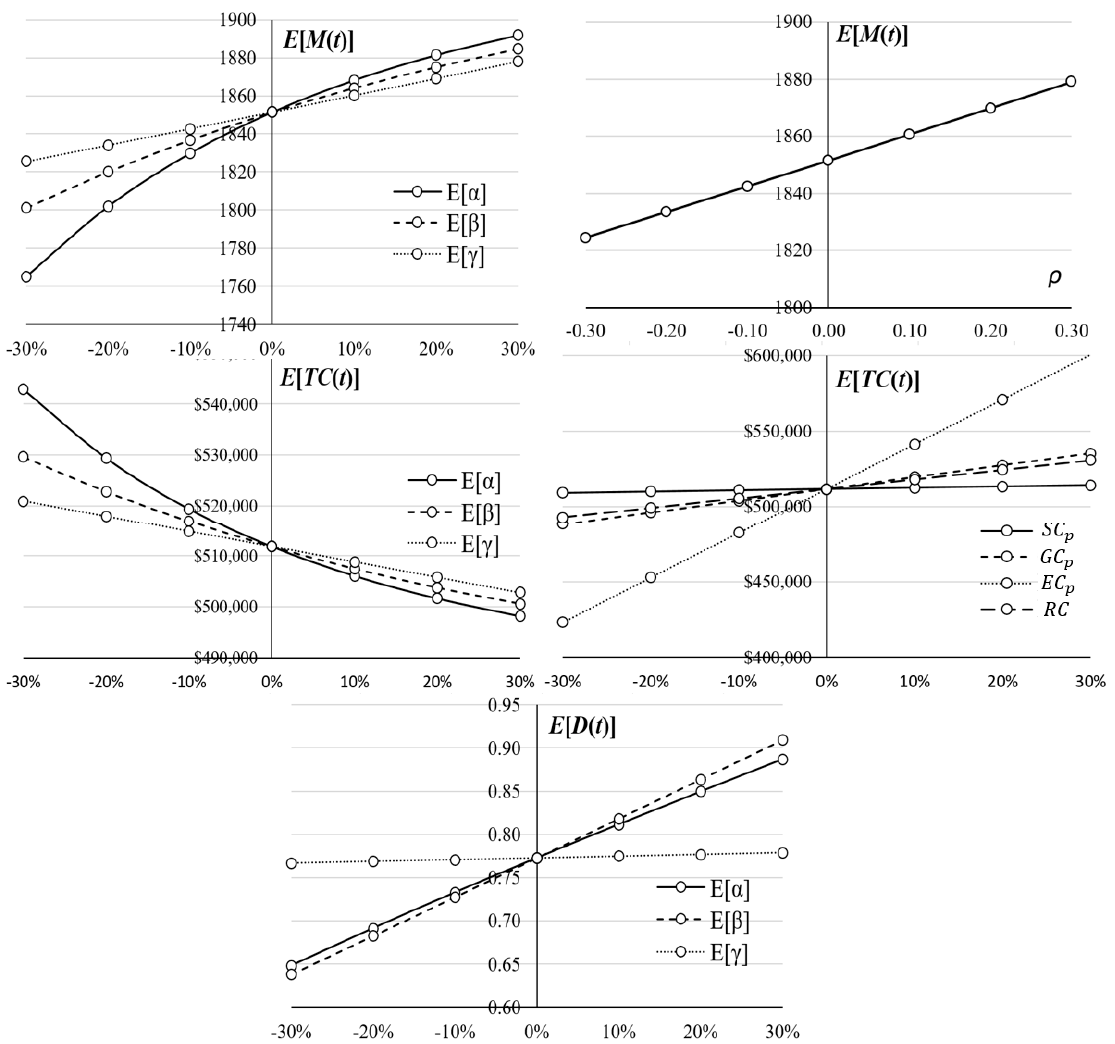
Figure 10. The impacts of model’s parameters and related costs. on 𝐸[𝑀(𝑇)] , 𝐸[𝑇𝐶(𝑇)] and 𝐸[𝐷(𝑇)] .